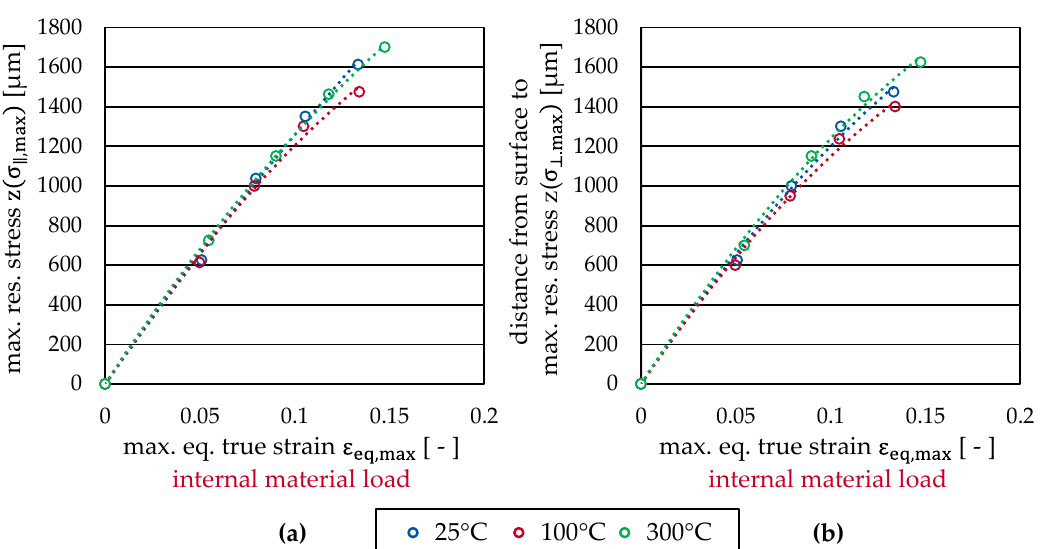
Figure 16. Simulated Process Signature Components for deep rolling describing the changes of maximal residual stress components in dependence of the maximal equivalent strain at different workpiece temperatures ( a ) for the maximum residual stress parallel to the rolling direction, and ( b ) for the maximum residual stress perpendicular to the rolling direc- tion. All values derived from simulations.